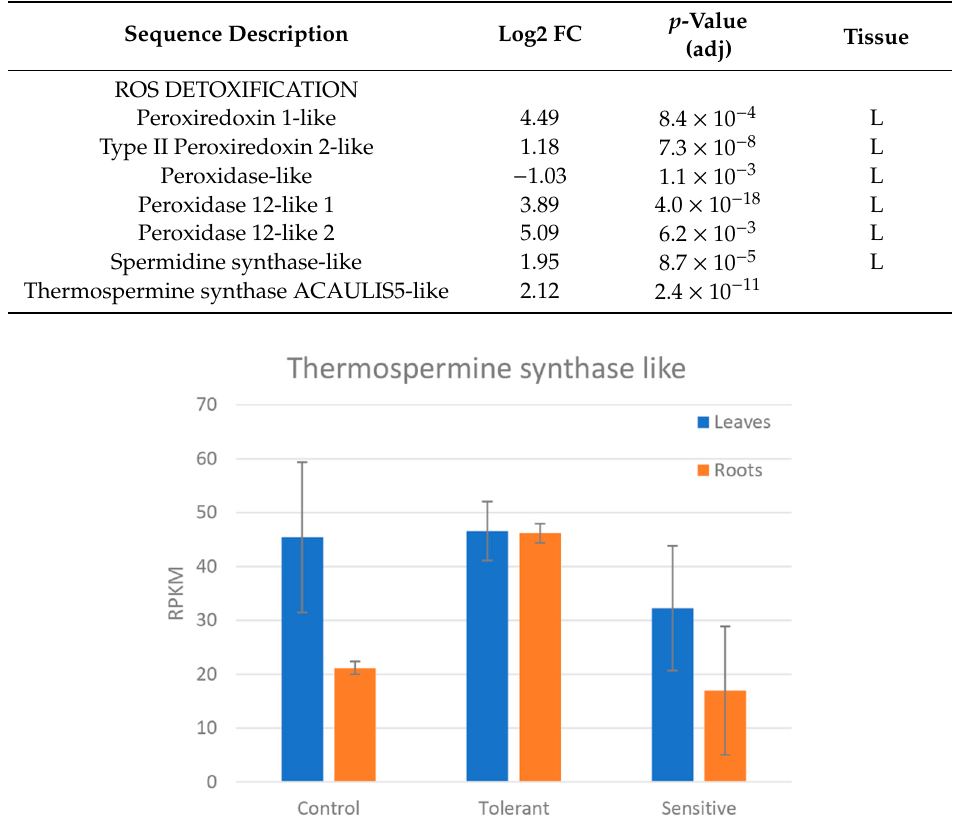
Figure 7. Reads per kilobase of transcript, per million mapped reads (RPKM) values of the differentially expressed thermospermine synthase-like gene between control, tolerant, and sensitive groups in leaves and roots. Bars represent standard deviation.